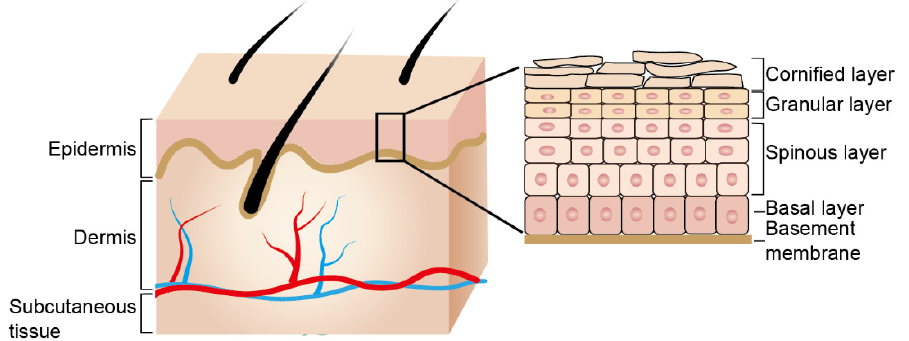
Figure 1. Structure of the skin and the skin epidermis. Skin is composed of three layers: epidermis, dermis and the deeper subcutaneous tissue. The dermis and epidermis are separated by basement membrane, where basal layer keratinocytes adhere. Keratinocytes of the basal layer undergo a terminal differentiation process and organize into distinct layers: spinous, granular and cornified layers.